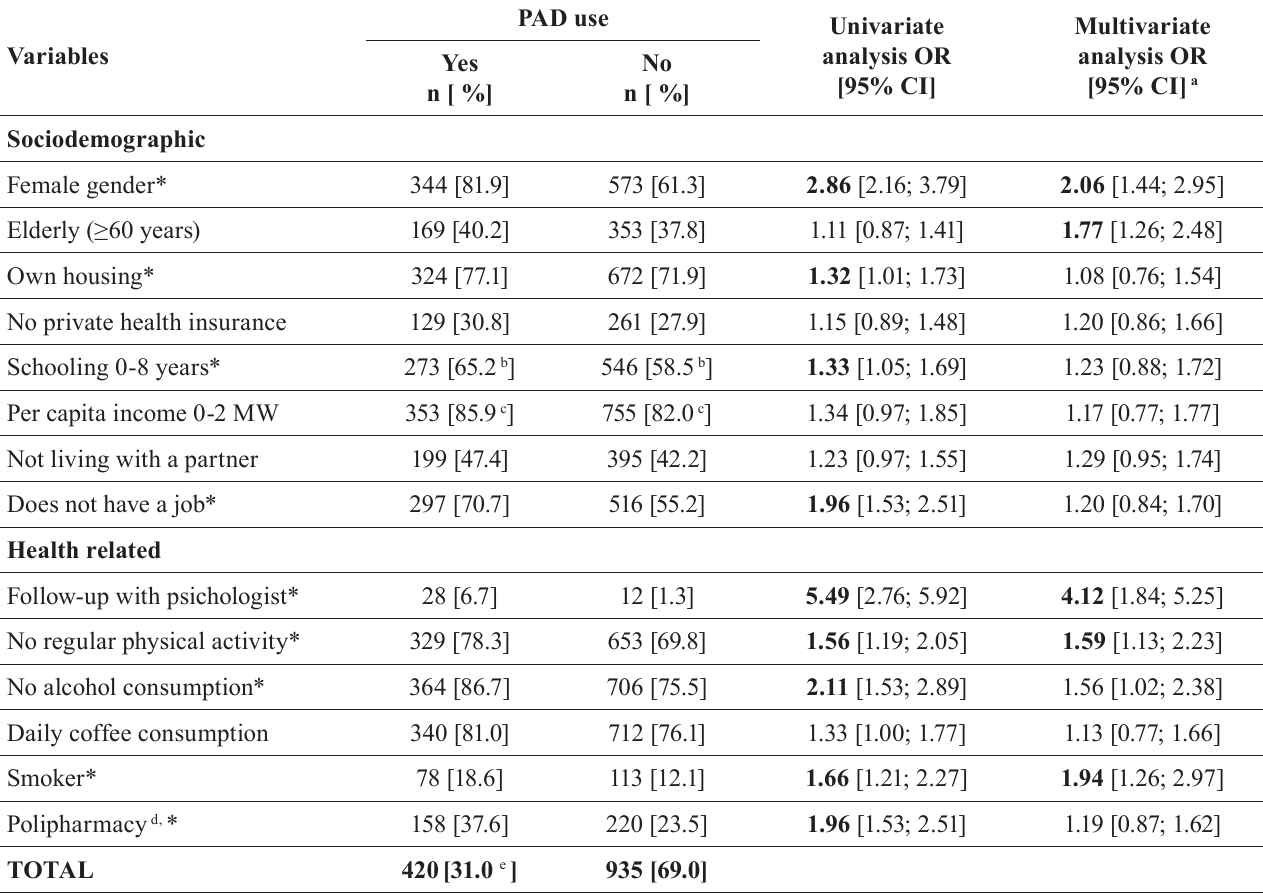
TABLE I - P revalence and PAD use characterization (n=1,355), December 2012